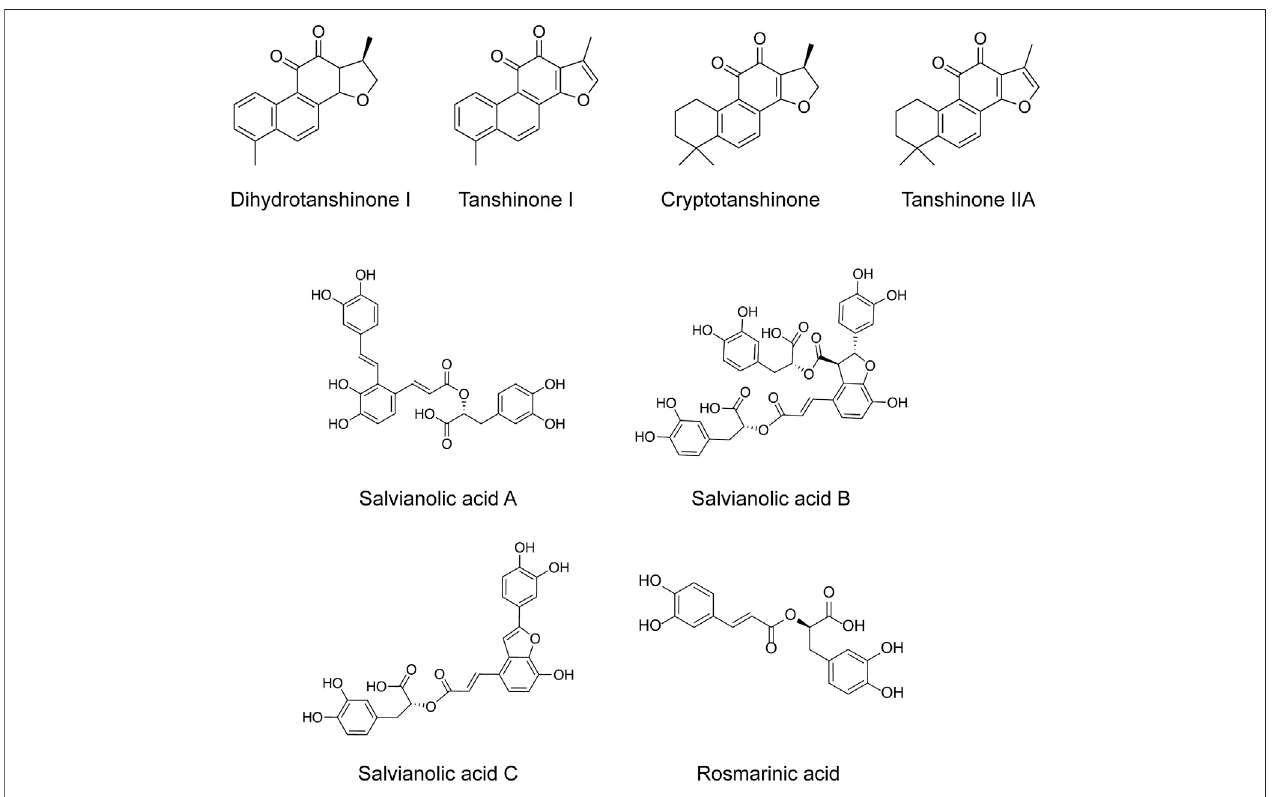
FIGURE 1 | The anti-breast cancer bioactive constituents present in S.